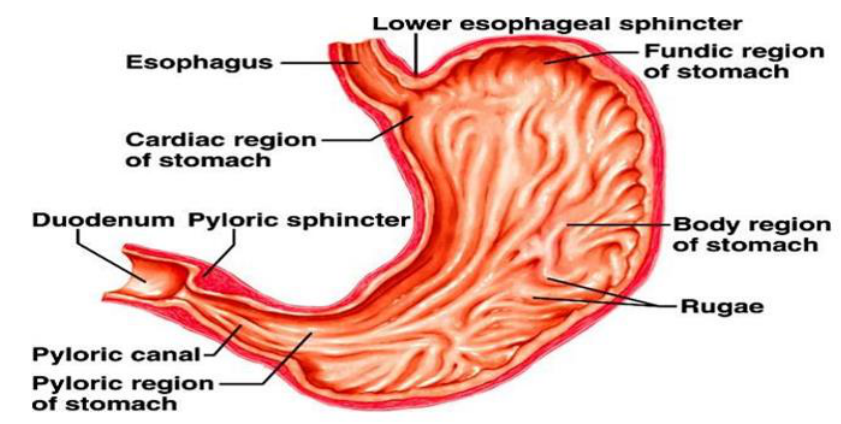
Fig. 3. Simplified anatomical illustration of the stomach (Henriksson et al.,